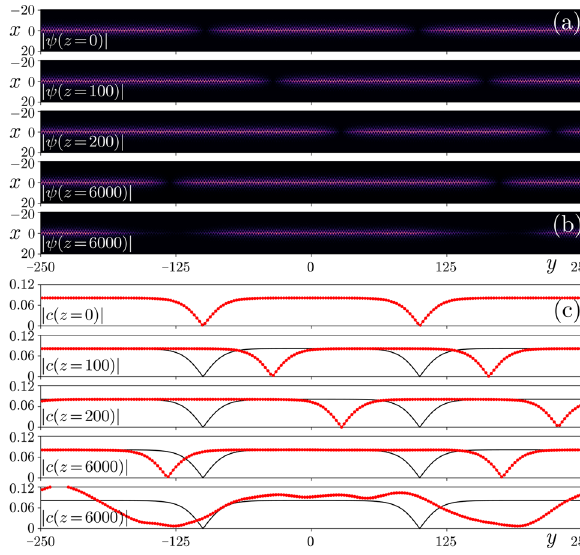
Figure 3: Dark topological edge soliton. (a)Selectedprofilesillustratingnonlinearpropagationofdarkvalley Hall edge soliton with b nl = 0.0014 (distances are shown in the left- bottom corner of each panel). (b) Output fi eld distribution at z = 6000 in a linear medium, for the same input as in panel (a). (c) Theoretical envelopes (solid curves) and amplitude projections (curveswith dots)at k y = − 0.3K. Forthe convenienceof presentation y -axis is made horizontal in this plot.